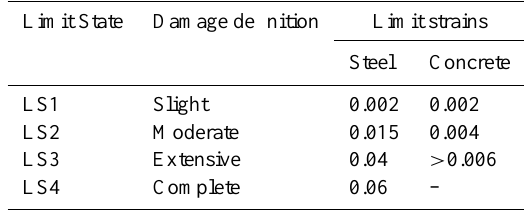
Table 2. Limit strain states proposed in this analysis for reinforce- ment steel and concrete